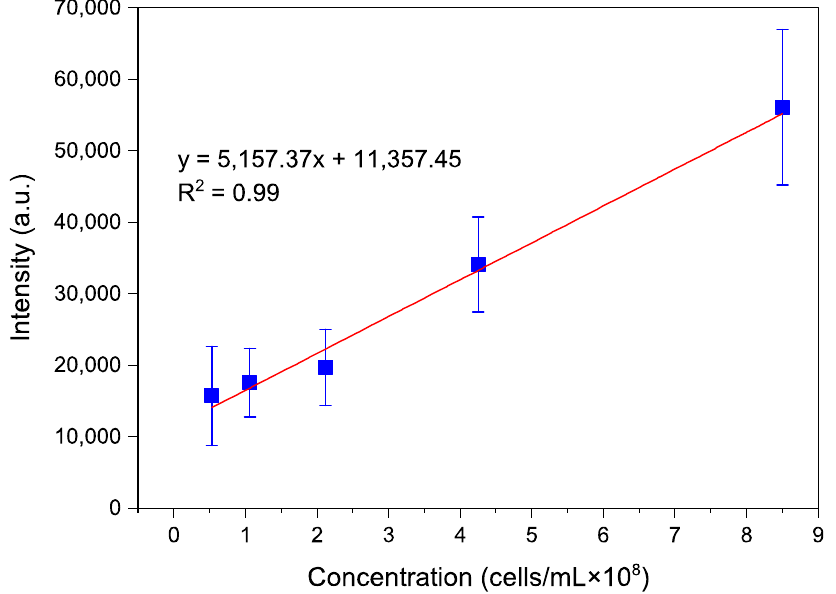
Figure 4. Calibration curve of fluorescence intensity against different concentrations of A. baumannii ; Error bars represent standard error ( n = 3). (Excitation wavelength: 320 nm; Emission wavelength: 531 nm).